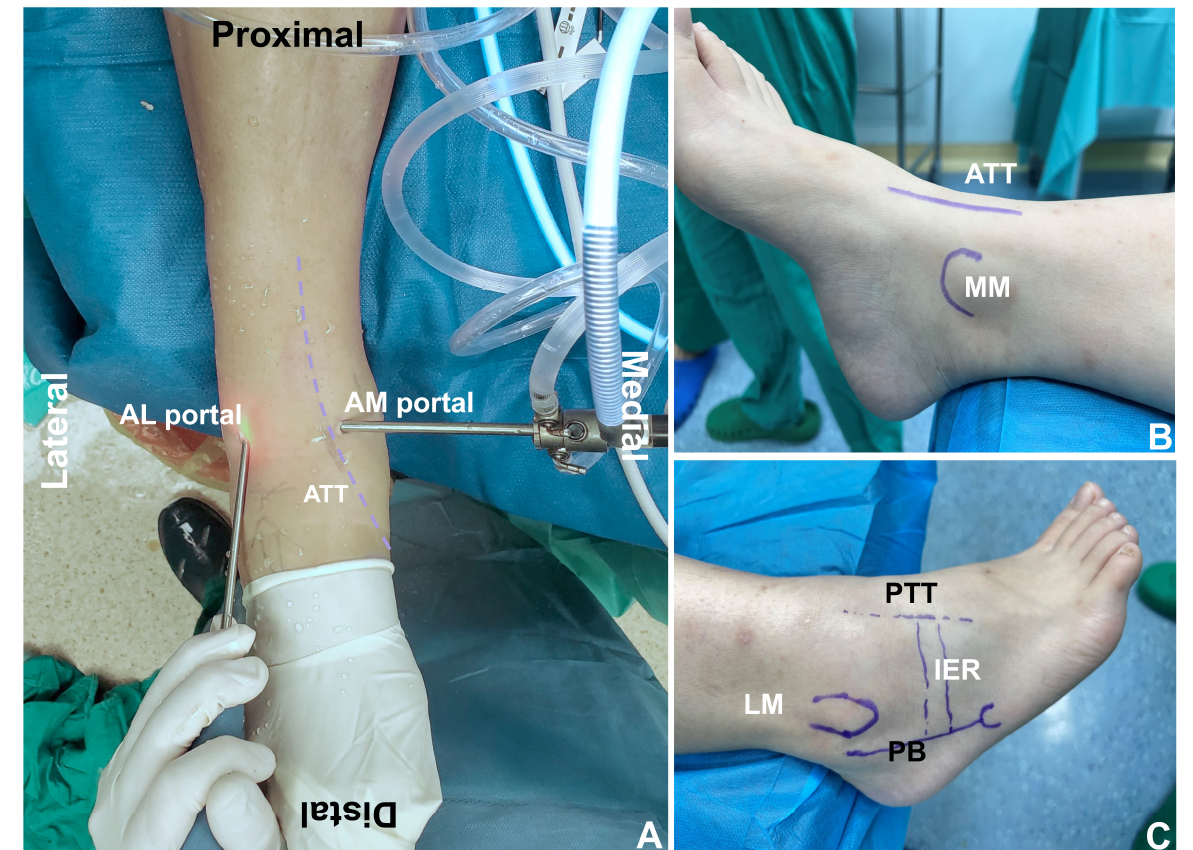
Figure 2. Portal placement and anatomic landmarks. ( A ) Anterior view. Indicate the anterior medial (AM) and anterior lateral (AL) portals. ATT: anterior tibial tendon. ( B ) Medial view. MM: medial malleolus. ( C ) Lateral view. PTT: peroneus tertius tendon, PB: peroneus brevis, IER: inferior extensor retinaculum, LM: lateral malleolus.